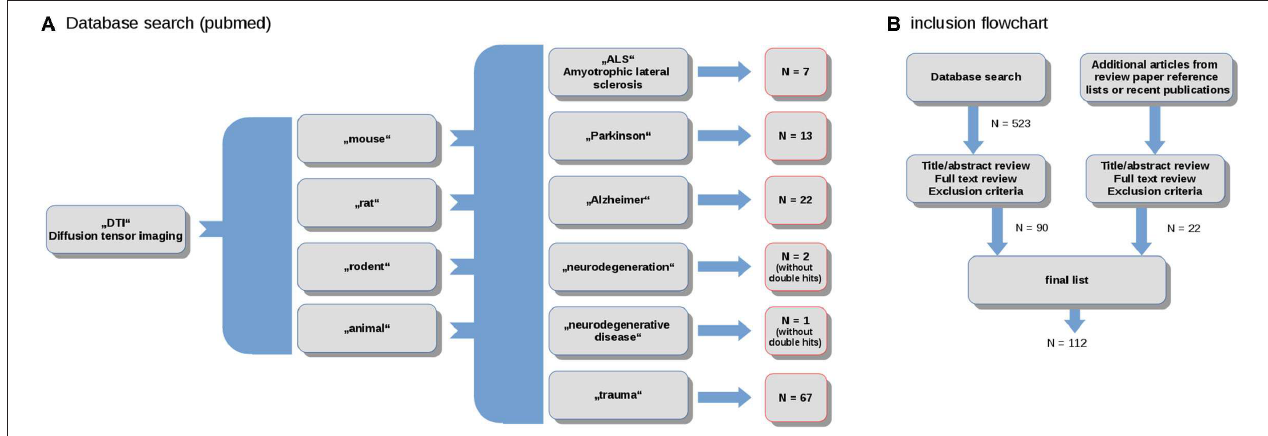
FIGURE 1 | (A) Selection diagram depicting the number of studies included for the spectrum of studied neurodegenerative diseases; and (B) PRISMA